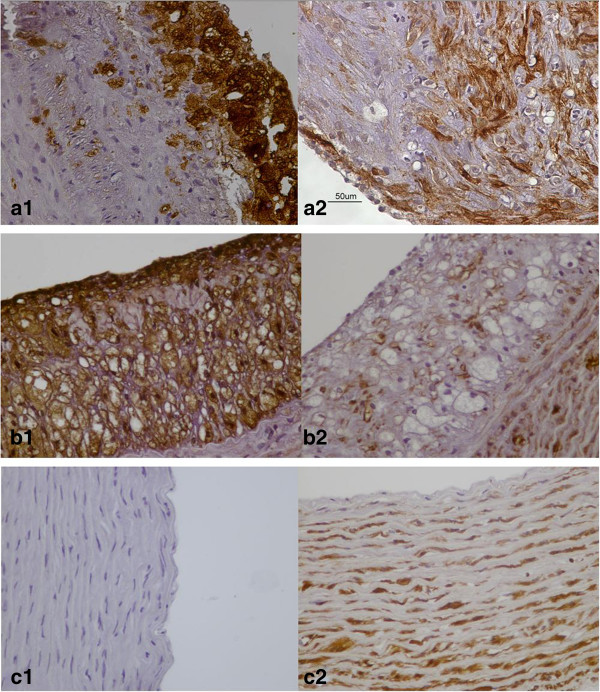
Ram-11 and HHF-35 staining in thoracic aortas. a1. Plethora RAM-11 positive foam cells, and a2. significant amounts of positive for a-actin SMCs are observed in angioplasty induced atherosclerotic lesions. b1. Significant foam cell formation, and b2. several a-actin positive SMCs between foam cells in spontaneous atherosclerotic lesions. c1. Lack of foam cell deposition, and c2. Normal presence of HHF-35 positive SMCs in the media of control aortas.